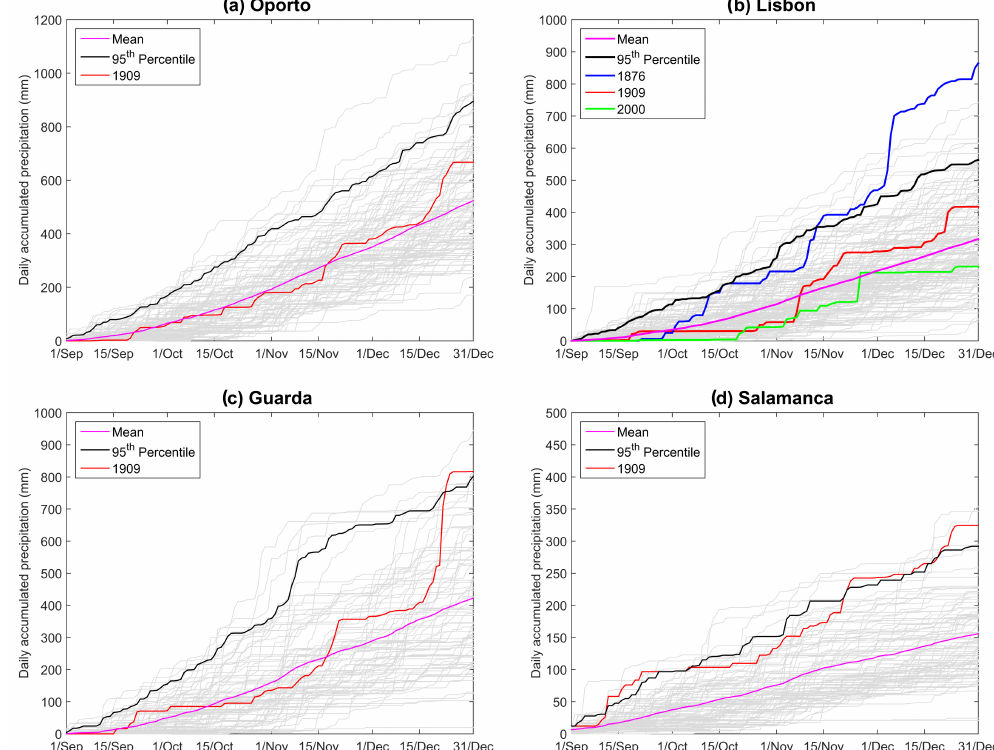
Figure 9. Cumulative precipitation from 1 September to 31 December using daily precipitation data from (a) Oporto, (b) Lisbon, (c) Guarda, and (d) Salamanca. Each year of cumulative precipitation is represented in grey. The mean and the 95th percentile of precipitation are represented in magenta and black respectively and accumulated precipitation in the year of 1909 is represented by the red line. In addition, the historical storm years of 1876 (blue) and 1967 (green) in Lisbon are also highlighted.